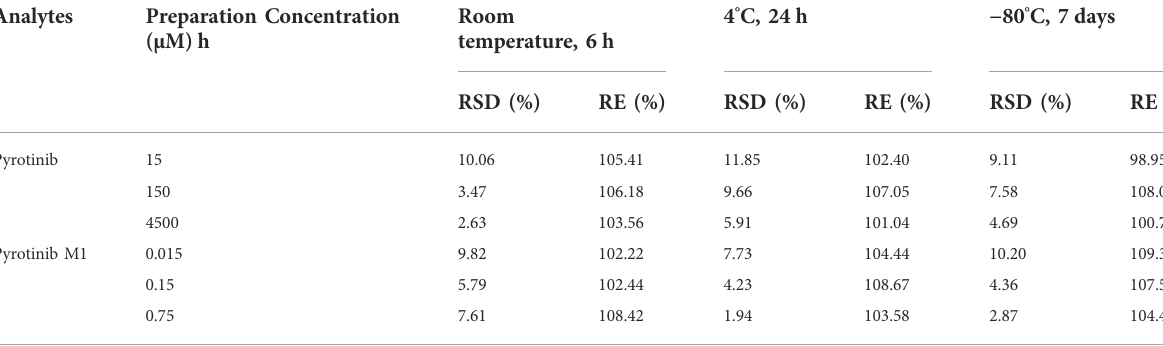
TABLE 3 Stability evaluation results of pyrotinib and pyrotinib M1 in rat plasma under different conditions ( n = 6).